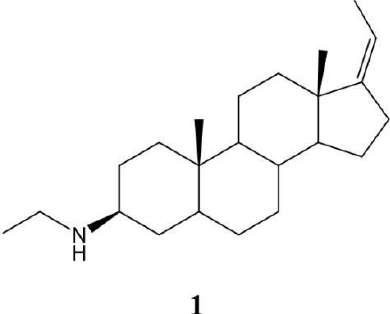
Figure 1. The chemical structure of compound 1 .